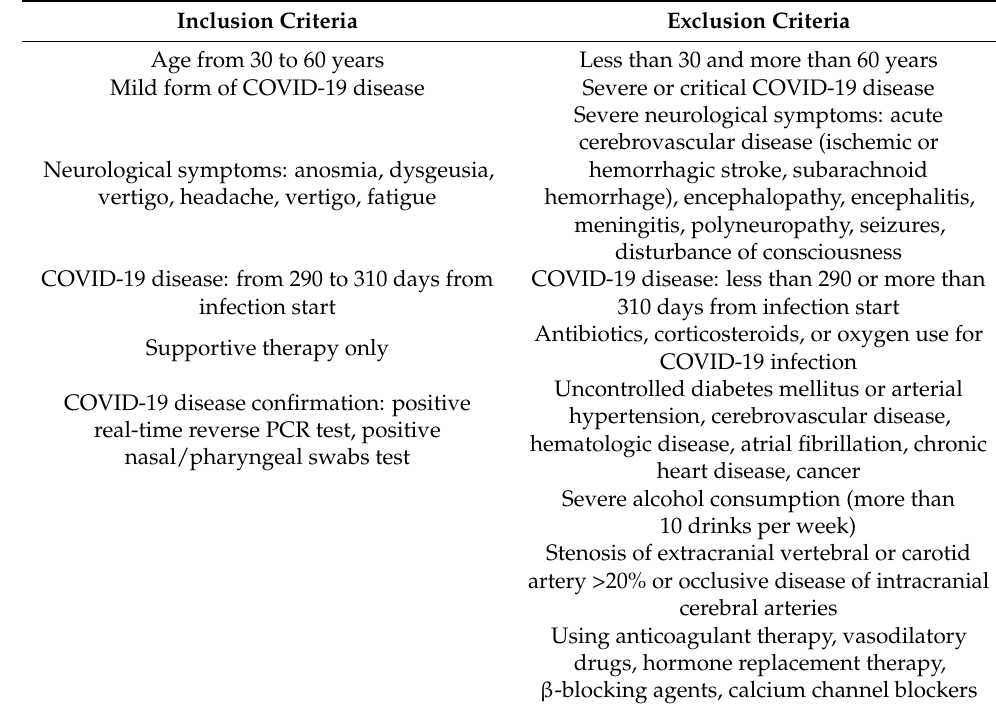
Table 1. Inclusion and exclusion